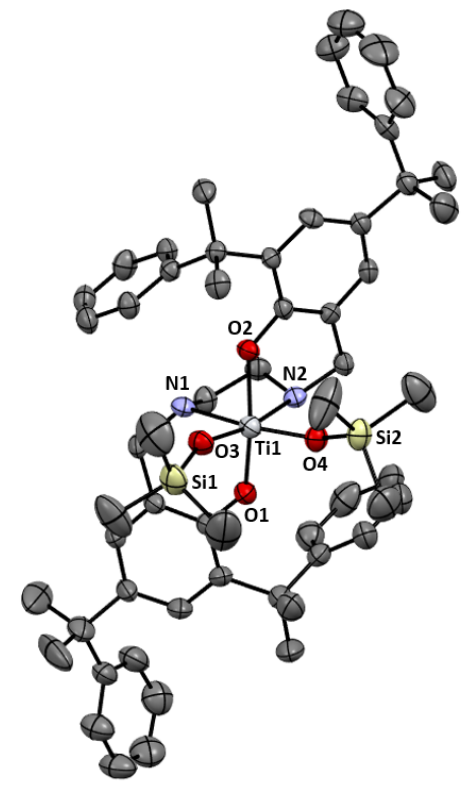
Figure 3. ORTEP diagram of [(H 2 N 2 O 2 )Ti(OSiMe 3 ) 2 ], 7 showing thermal ellipsoids at 35% probability level. Hydrogens atoms were omitted by clarity. Selected bond lengths (Å) and angles (°): Ti(1)-N(1) 2.252(4), Ti(1)-N(2) 2.257(4), Ti(1)-O(1) 1.882(3), Ti(1)-O(2) 1.899(3), Ti(1)-O(3) 1.820(3),